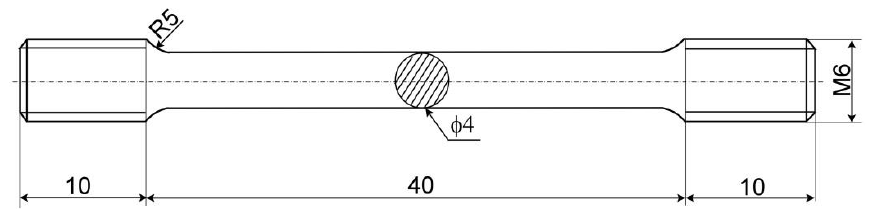
Figure 1. Cylindrical tensile test specimens (all dimensions are in mm).